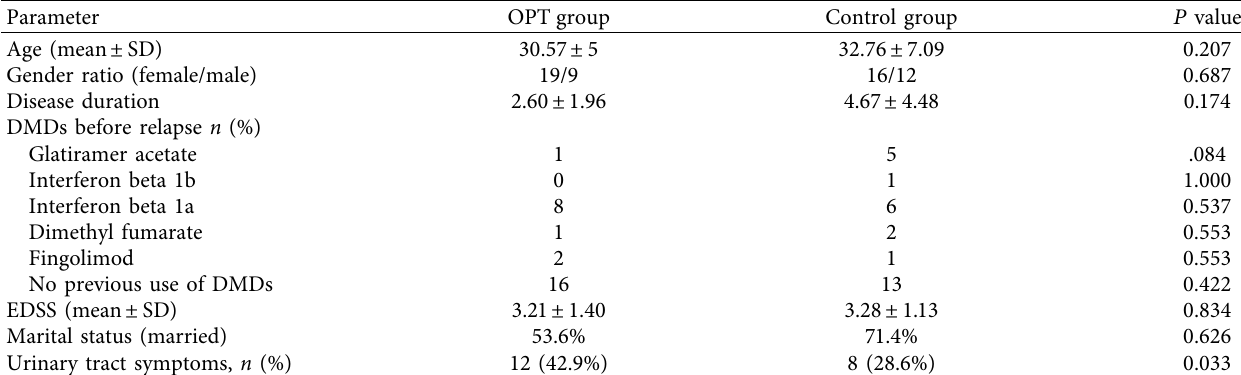
Table 1: Baseline characteristics of the study population.